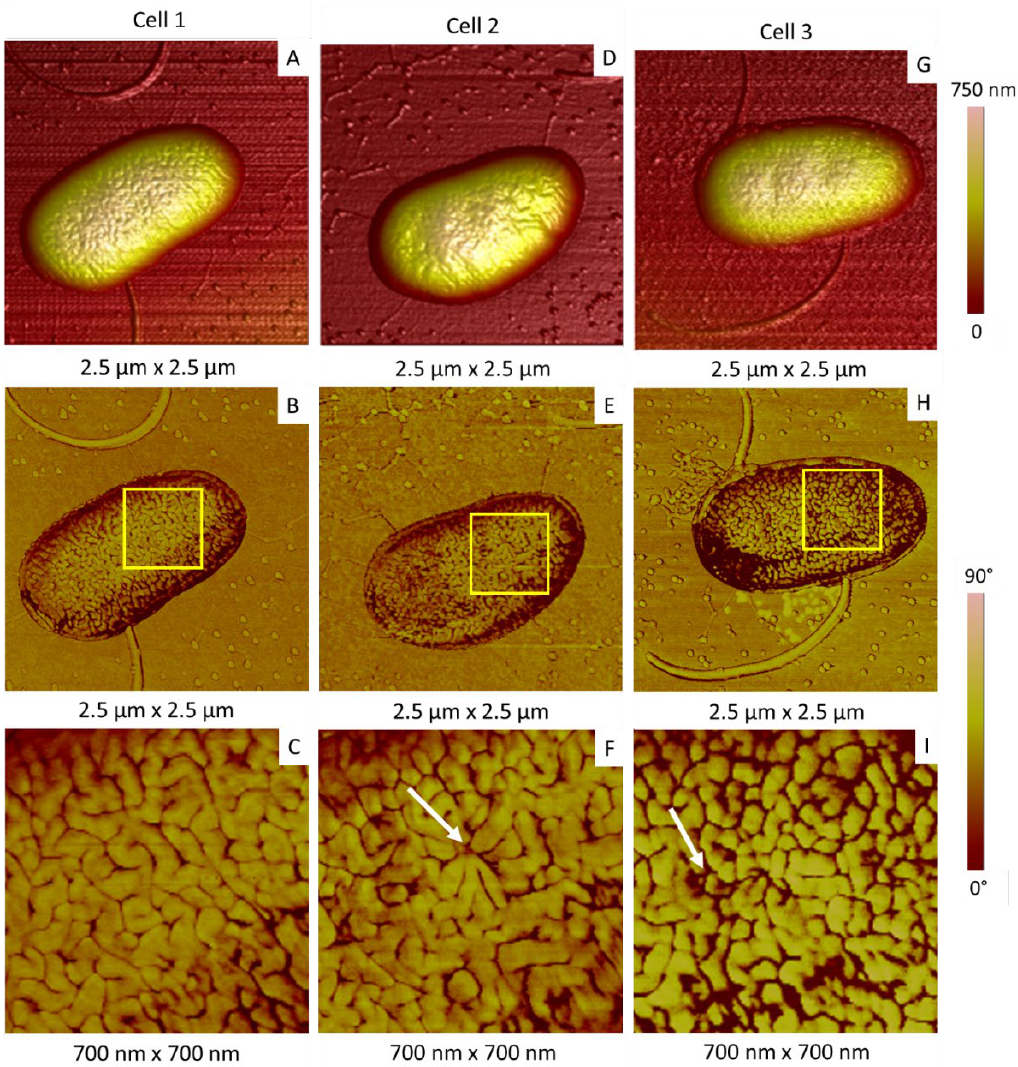
Figure 7. Relationship between membrane organization and invaginations. ( A , D , G ) AFM 3D topographic images of three bacteria; ( B , E , F ) corresponding phase images; AFM images shown in ( C , F , I ) correspond to the areas in the squares indicated in ( B , E , H ), respectively. White arrows indicate the bottom of the